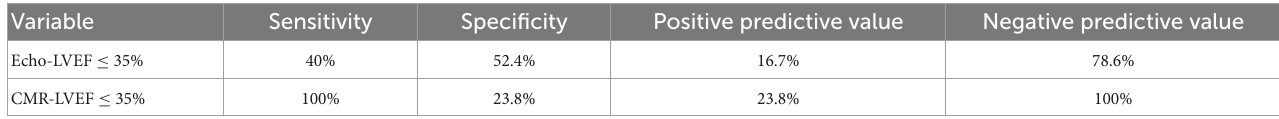
TABLE 2 ROC curve characteristics of LVEF categories by Echo and CMR before ICD implantation to predict appropriate ICD-T. Variable